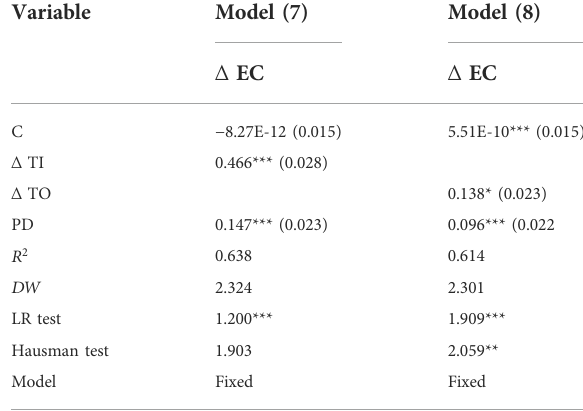
TABLE 7 Test results for the regulating effect of enterprise size. Variable